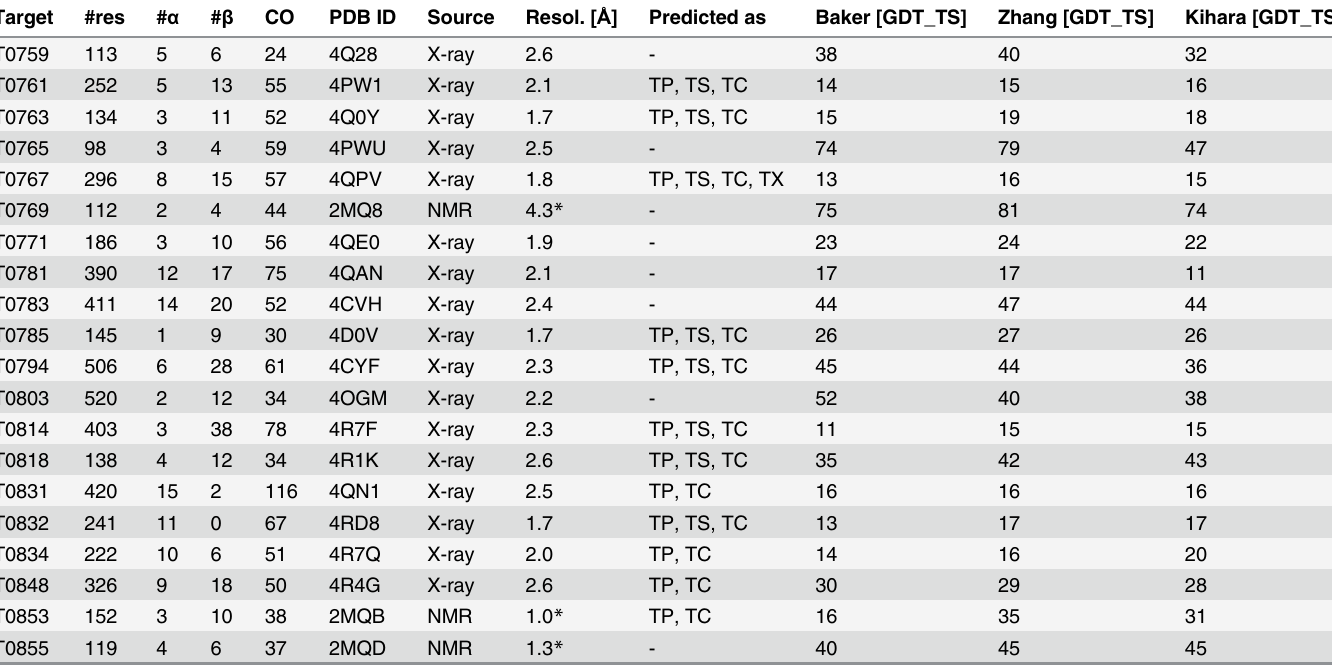
Table 1. The proteins used in this study for the CASP11